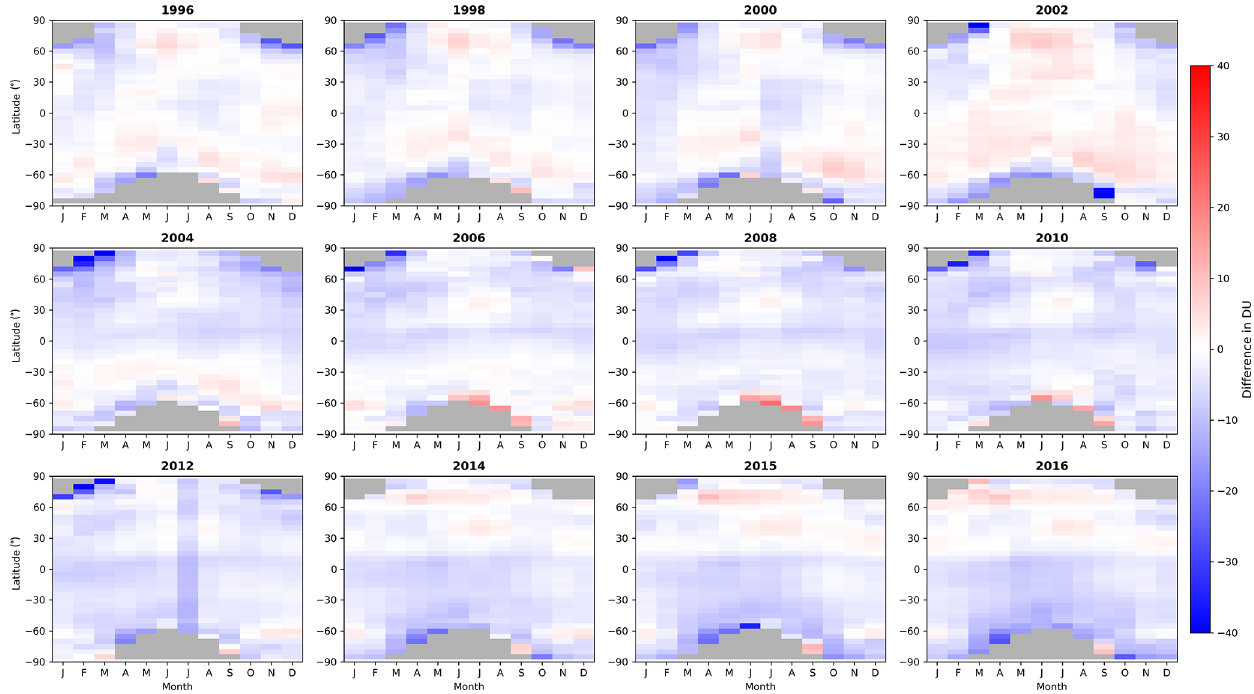
Figure 11. Differences between monthly mean 5 ◦ zonal mean TCO calculated from the NIWA-BS and GSG Bremen databases for 12 selected years (NIWA-BS minus GSG).